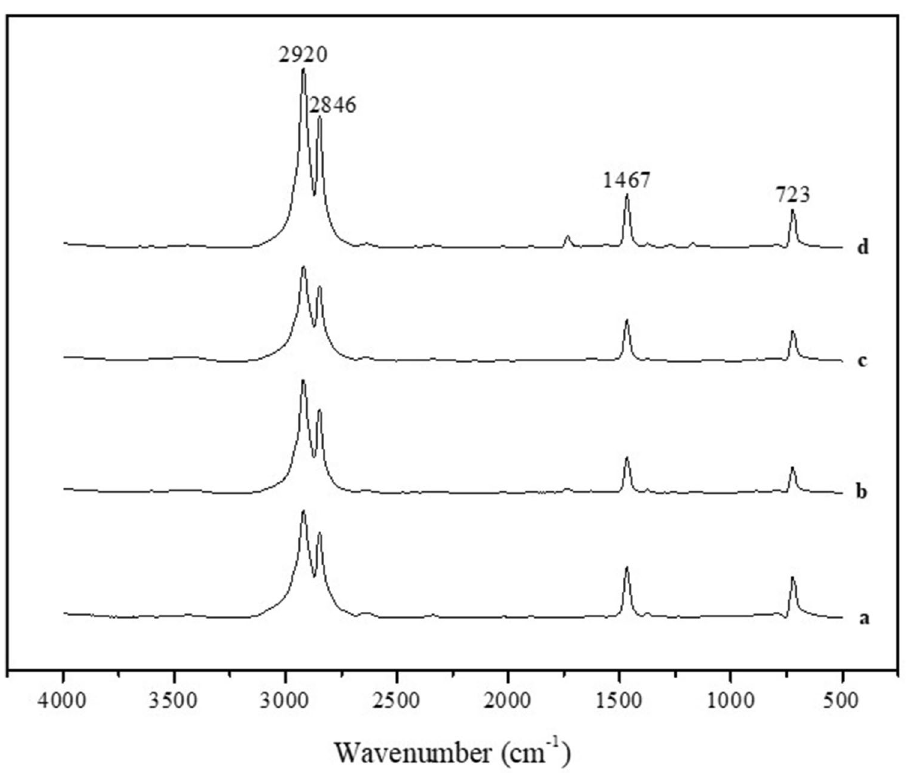
Figure 3. FT-IR spectra of PE microspheres ( a ) before digestion and after KOH digestion in ( b ) cleansing cream A, ( c ) cleansing cream B and ( d ) cleansing cream